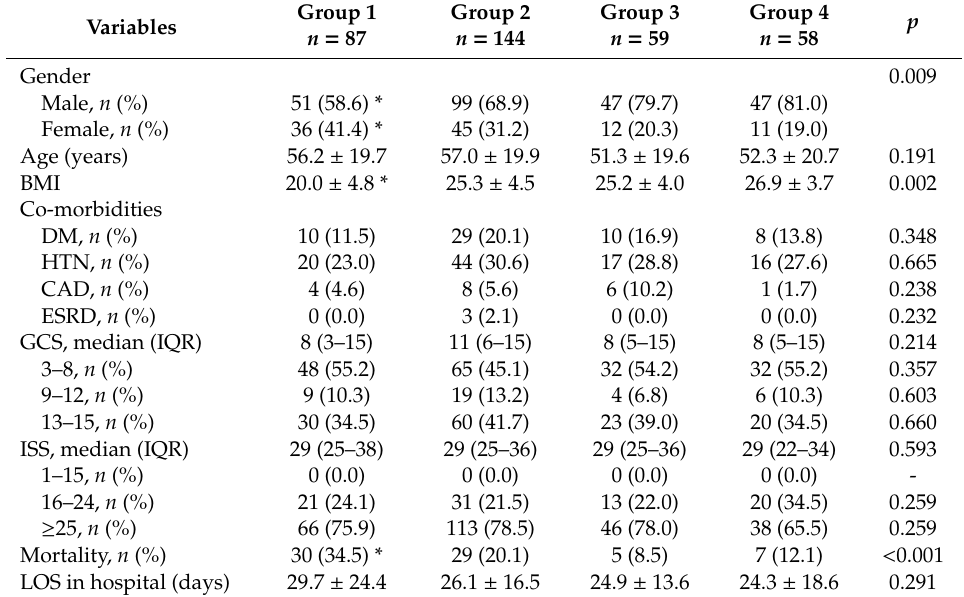
Table 3. Patient and injury characteristics of the adult polytrauma patients with di ff erent risks for